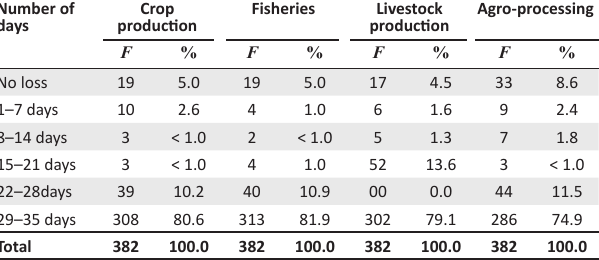
TABLE 5: Number of working days lost in agricultural sector in Adamawa. Number of Crop days production